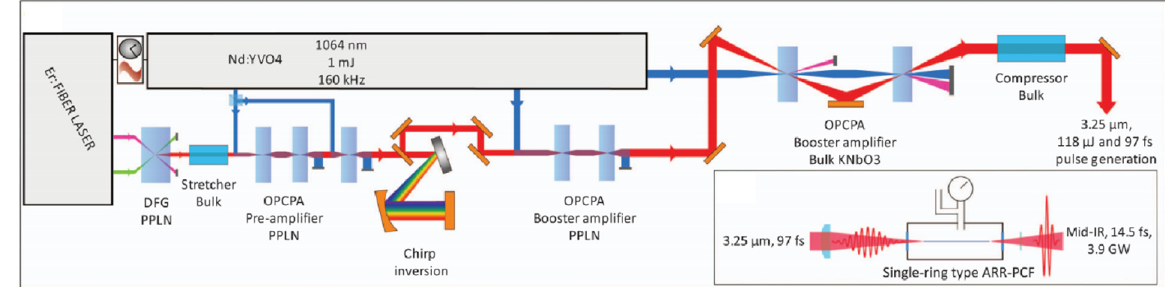
Figure 9. Setup of the high-power, MIR OPCPA system. The seed was generated by a two-color fiber front-end in combination with a DFG stage. Afterward, the MIR pulses were stretched and consecutively amplified in a pre-amplifier and two booster amplifiers. Maximum conversion efficiencies were achieved by multiple uses of the pump beam and by individually tailored seed-to-pump pulse durations. Reprinted with permission from [49].